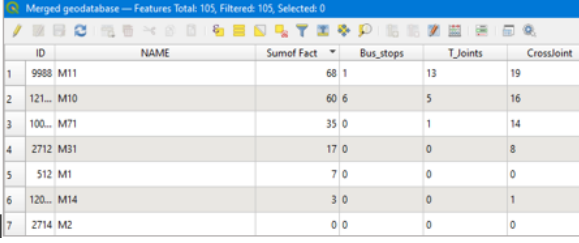
Figure 5 . The attribute table of the merged road feature class.